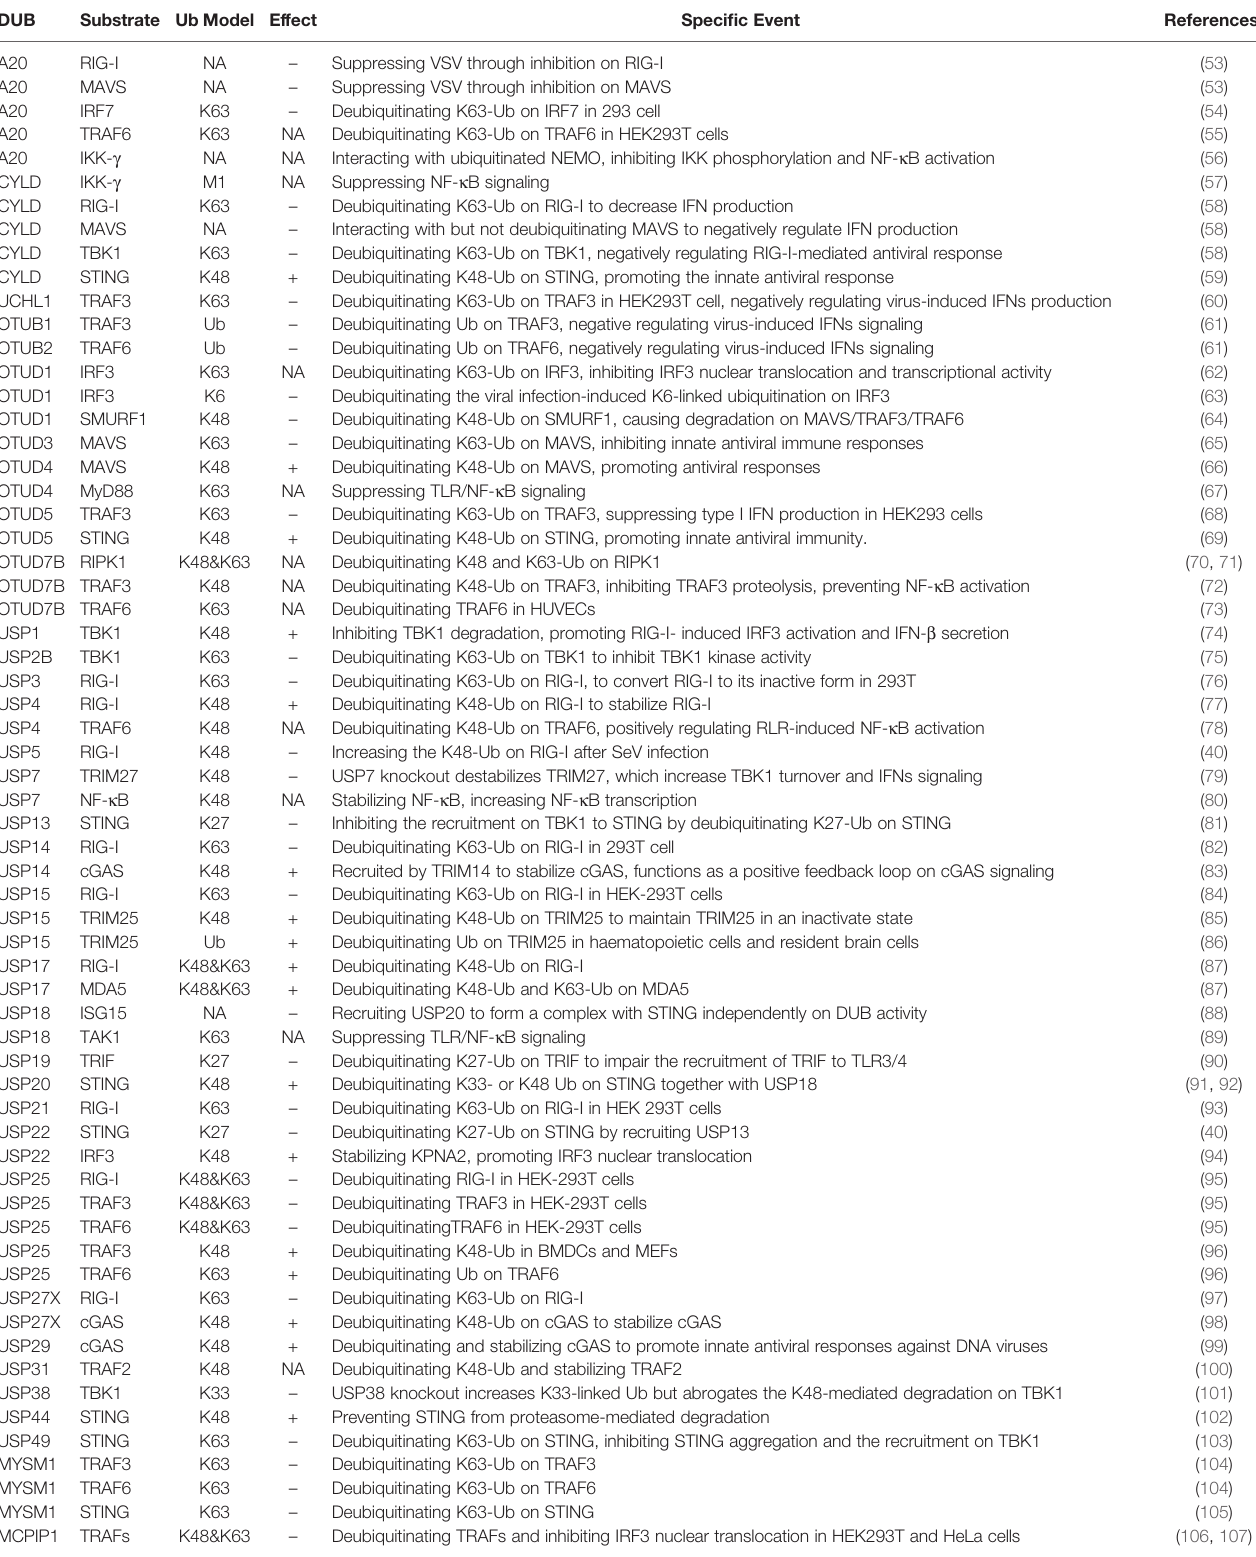
TABLE 1 | Summary on human DUBs involved in the regulation on IFN-I signaling and antiviral responses. DUB Substrate Ub Model